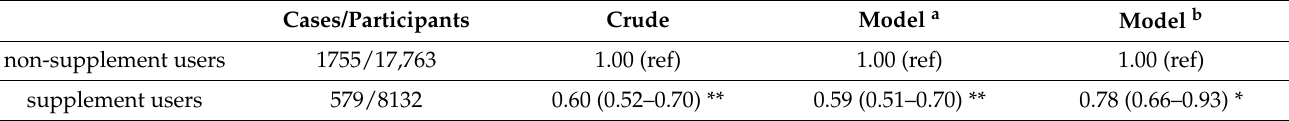
Table 6. Association between vitamin C supplement users and non-supplement users with depressive symptoms.